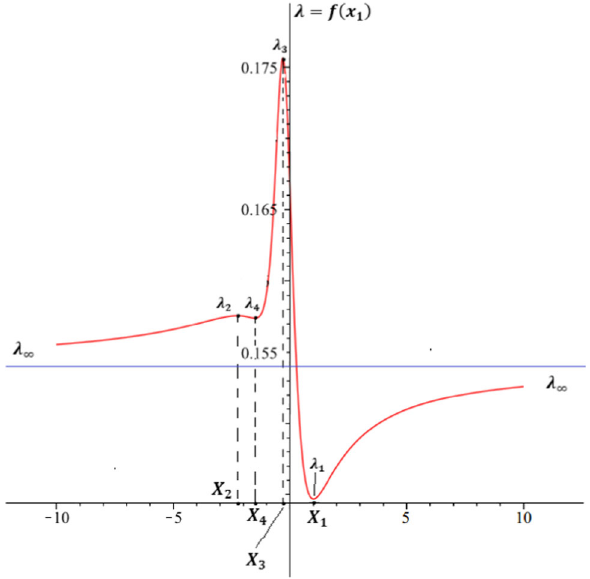
Fig. 2 The function λ = f ( x 1 ) for m = 4, k 1 = 5, k 2 =